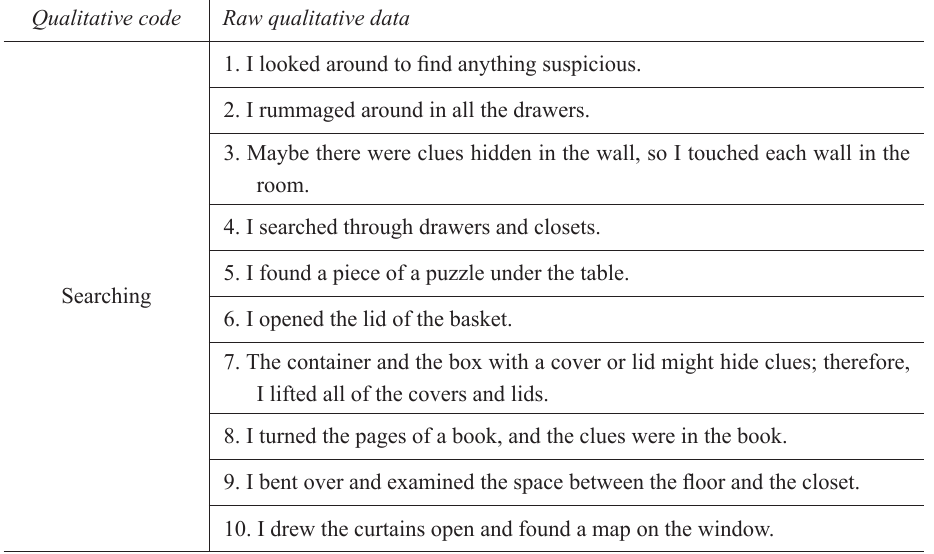
Table 5. Sample raw data from group interviews supporting the qualitative codes Qualitative